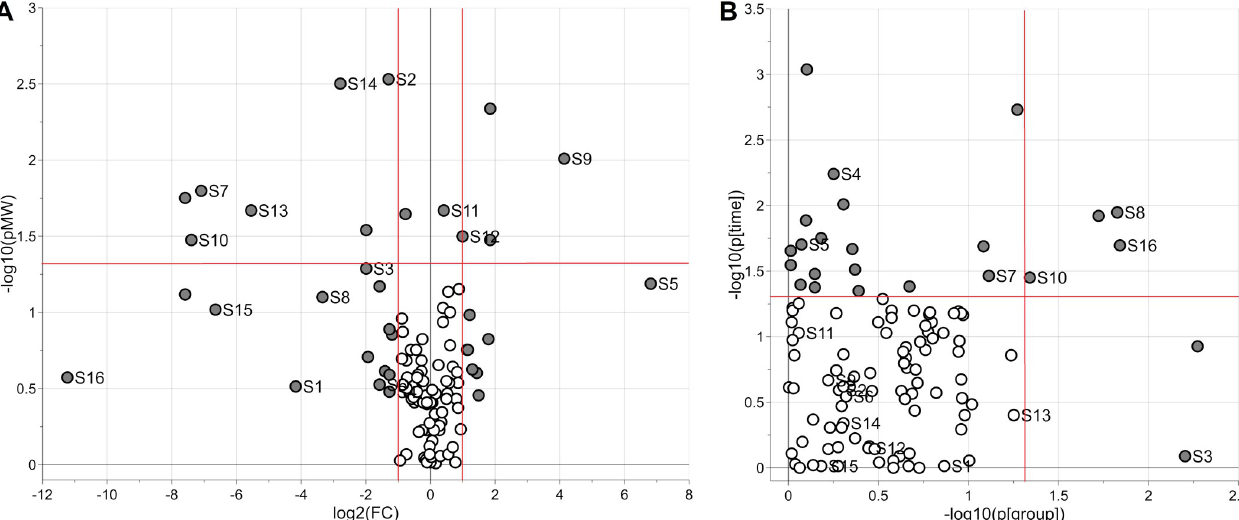
Fig 2. Analysis of the metabolic signature discovered by PLS for classification. The Volcano plot (panel A) shows the negative logarithm of the p-value of the Mann-Whitney test (vertical axis) versus the logarithm of the fold change calculated as the ratio between the median of the “HIE” group and the median of the “no HIE” group (horizontal axis). Panel B shows the negative logarithm of the p-value of time (vertical axis) and the negative logarithm of the p-value of the factor group with levels “HIE” and “no HIE” (horizontal axis) obtained by LME modelling. Metabolites showing fold change greater than 2 or p- value < 0.05 are reported as grey circles. Thresholds at the significance level α = 0.05, and the limits corresponding to a 2-fold change are shown as red lines. In figure, annotated metabolites are indicated as follows: S1 = 19-hydroxyandrost-4-ene-3,17-dione, S2 = 2,6 dimethylheptanoyl carnitine, S3 = 2-methyl- dodecanedioic acid, S4 = 3-mercaptolactate-cysteine disulfide, S5 = Creatine, S6 = Dihydrostreptomycin 6-phosphate, S7 = Glycylprolylhydroxyproline, S8 = L-3-methylhistidine, S9 = L-alanine, S10 = L-lysine, S11 = L-prolyl-L-phenylalanine, S12 = N-methylethanolamine phosphate, S13 = Norcotinine, S14 = Octanoylglucuronide, S15 = Proline betaine, S16 = S-(2-methylpropionyl)-dihydrolipoamide-E.